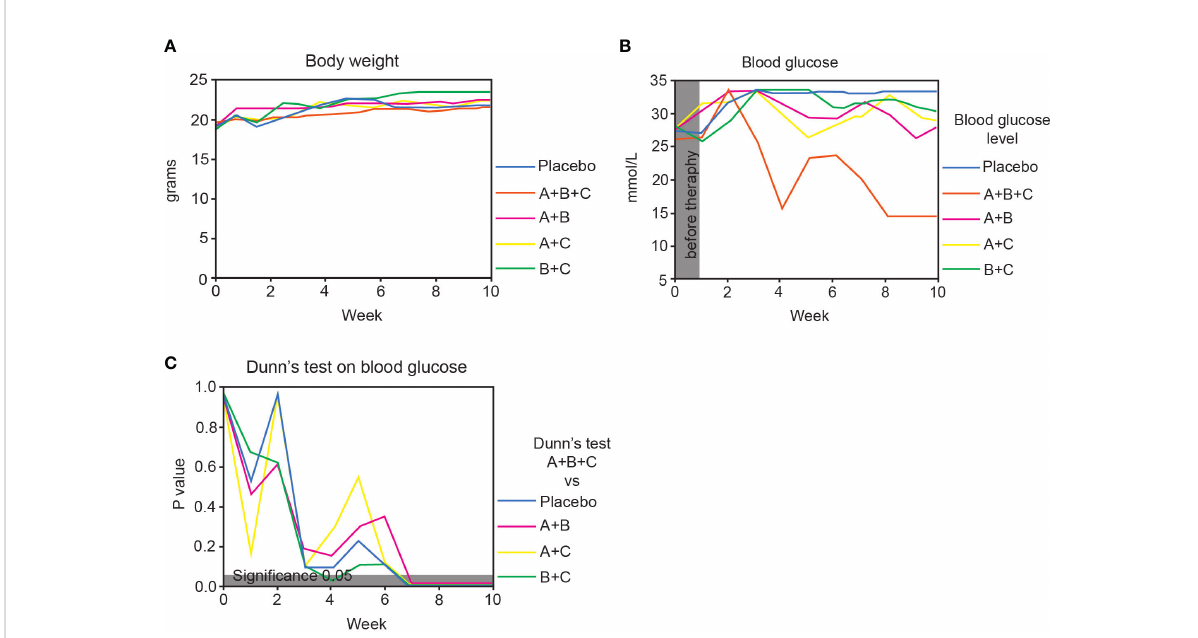
FIGURE 2 Triple therapy (A+B+C) promotes diabetes reversal in NOD mice. This arm of the experiments was performed on 51 mice that had developed diabetes at the start of drug therapy (blood glucose >13.9 mmol/L). The placebo, A+B, A+C and B+C groups included 10 mice each and the A+B+C group 11. (A) Changes in body weight of the mice in each group are shown as median values. The data were analyzed with the Kruskal- Wallis test with Dunn ’ s post hoc . No signi fi cant changes were found between the groups. (B) Changes in median blood glucose levels in each group over 10 weeks. (C) Blood glucose levels of the A+B+C group were compared with the other groups at different times using the Kruskal- Wallis test with Dunn ’ s post hoc . The gray area corresponds to a level of signi fi cance (p =